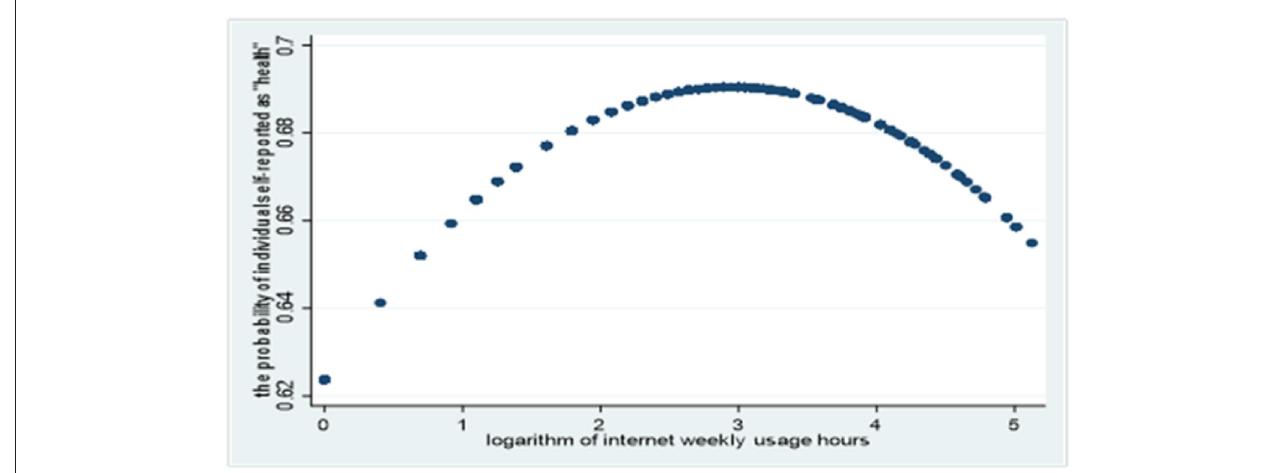
FIGURE 1 | Relationship between the logarithm of Internet weekly usage hours and the degree of depression.